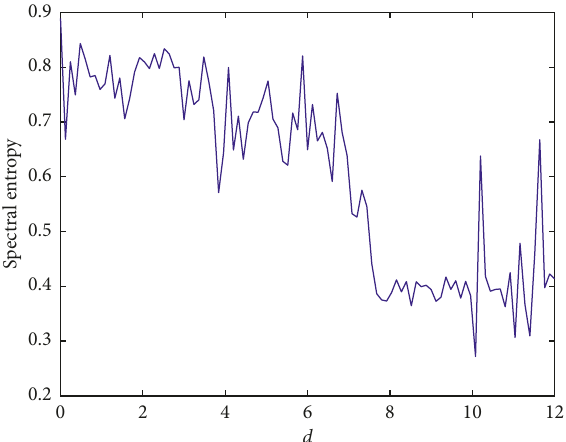
Figure 4: The complexity of spectral entropy for increasing parameter d .